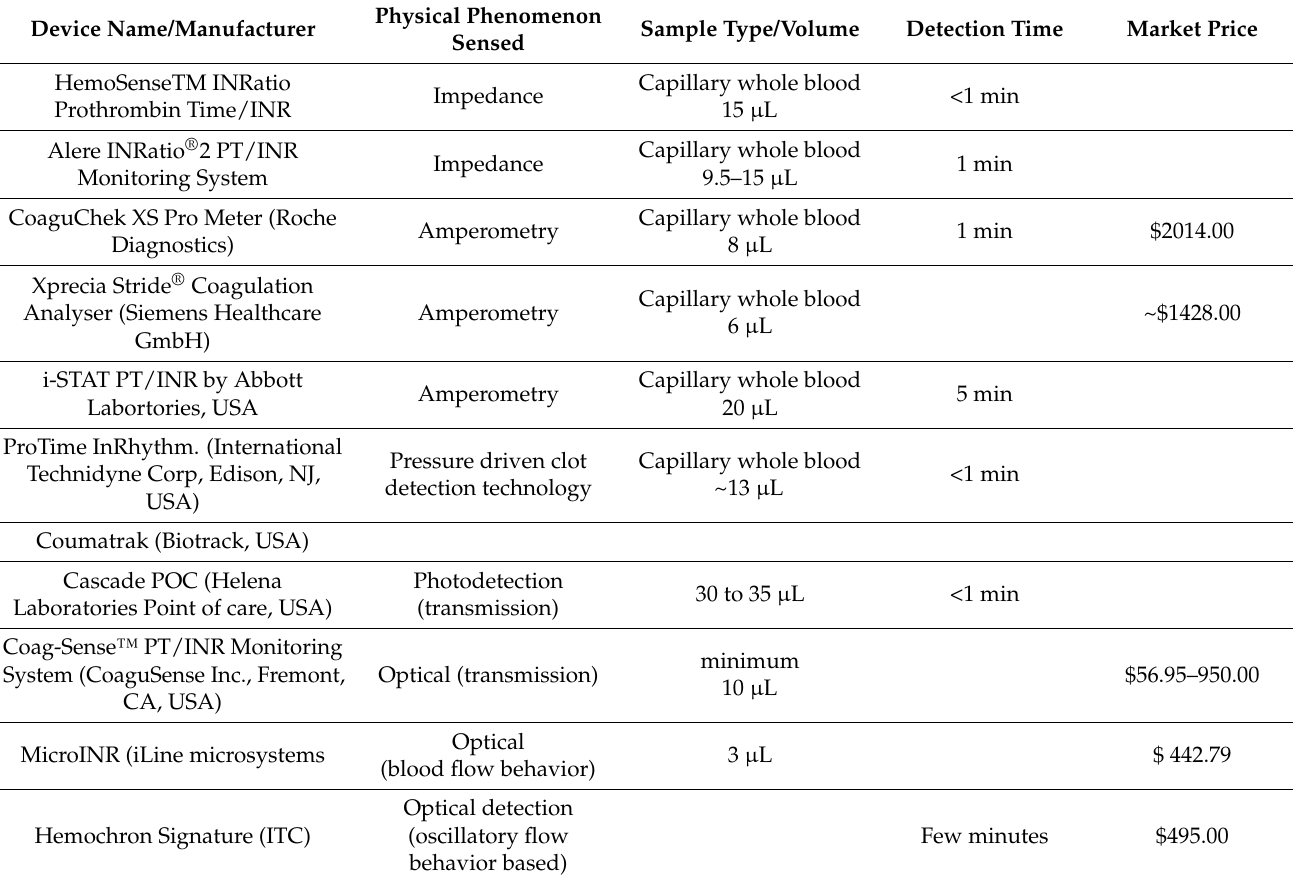
Table 3. Some popular commercially available coagulation (PT/INR) monitoring